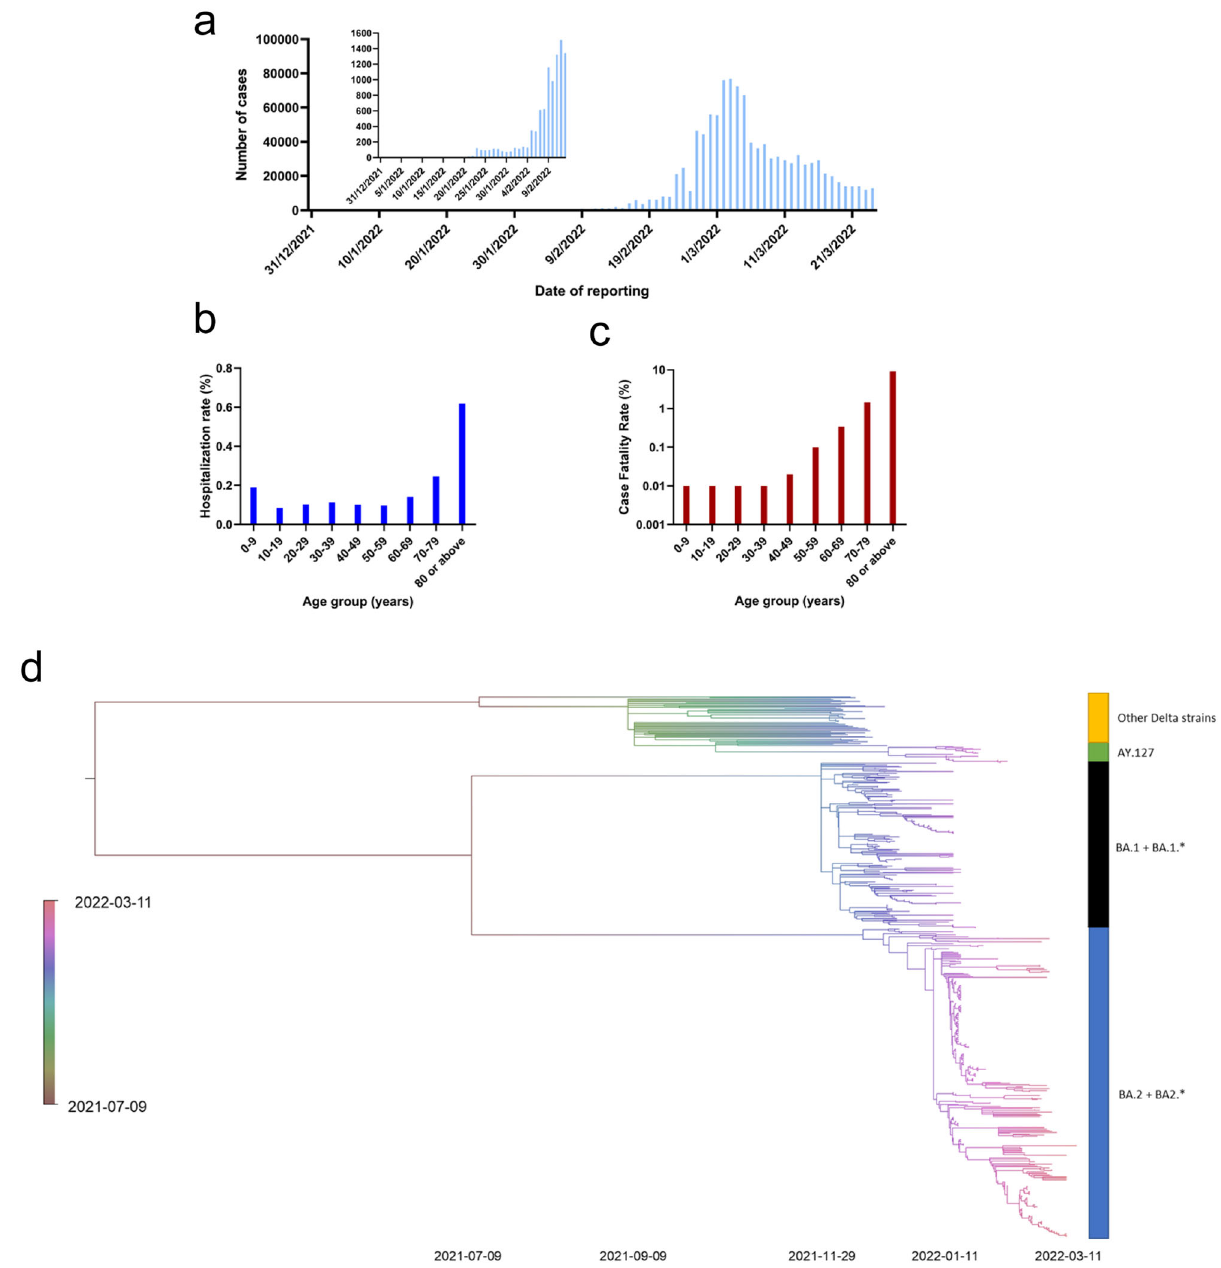
Fig. 4 Epidemiology and genomic analysis of the fi fth wave of COVID-19 in Hong Kong. a Epidemic curve showing the incidence of COVID-19 cases between December 31, 2021 and March 24, 2022. b Age speci fi c incidence rate of COVID-19 related hospitalization in Hong Kong as of February 24, 2022. c Age speci fi c case-fatality rate of COVID-19 as of March 24, 2022 44 . d Time-resolved phylogenetic tree of 545 viral genomes from Dec 1, 2021 to March 11 2022. BA.1.* includes BA.1.1, BA.1.1.1, BA.1.1.10, BA.1.1.13, BA.1.1.14, BA.1.1.16, BA.1.1.18, BA.1.1.2, BA.1.14, BA.1.15, BA.1.15.1, BA.1.17, BA.1.17.2 and BA.1.18. BA.2.* includes BA.2.2, BA.2.3, and BA.2.10. Details of the sequences used are shown in Supplementary Data 1. Source data are provided as a Source Data fi